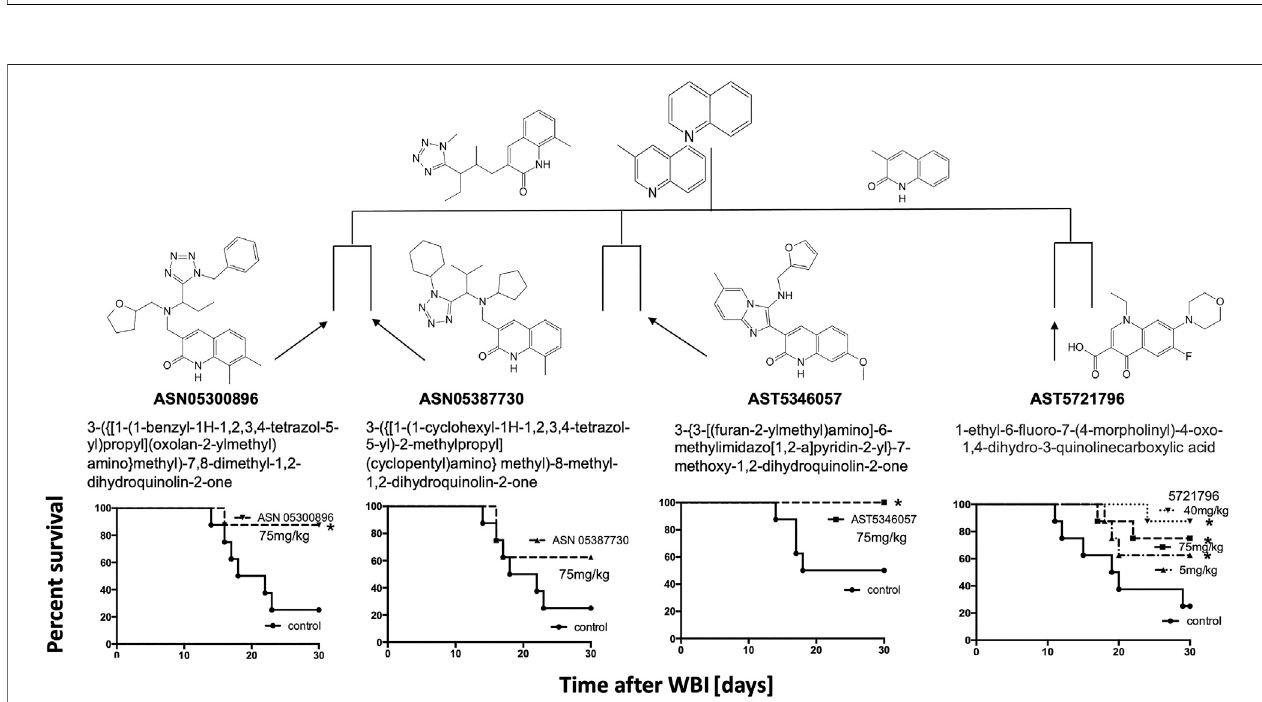
FIGURE5| Activity ofthe quinoline classofradiomitigatorsofH-ARS inC3H male micewithdrugsgiven s.c., atthestated doses(5 × daily) starting1 dafter LD70/ 30 doses of radiation (Cs-137). * p < 0.05, *** p < 0.001.